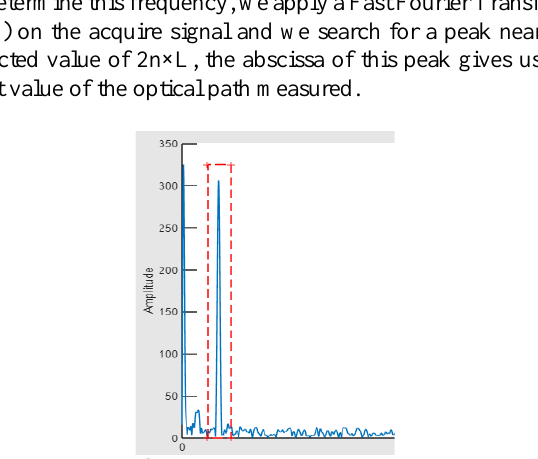
Figure 3: Example of a FFT applied to an experimental signal. The red rectangle corresponds to the domain where we expect to find a peak beforehand. The X-axis corresponds to the optical length measured